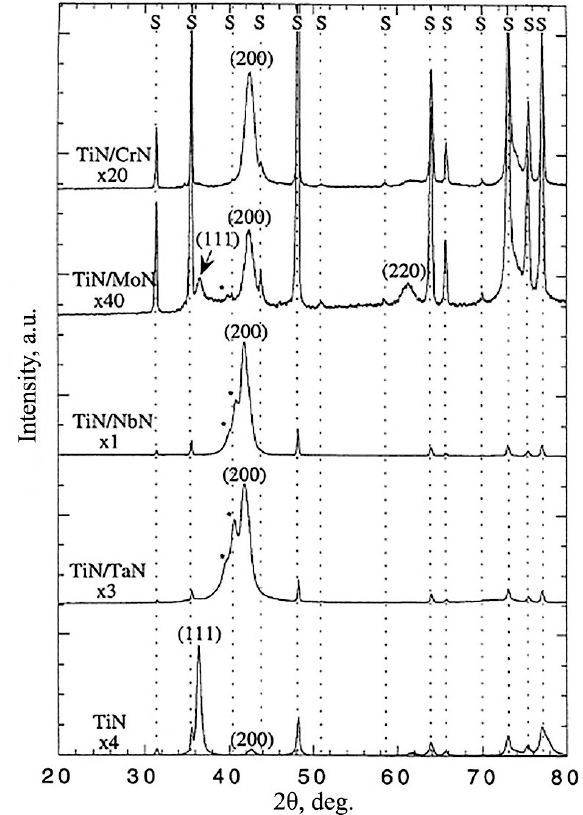
Figure 6. X-ray diffraction patterns of TiN/CrN, TiN/MoN, TiN/NbN and TiN/TaN coatings; “S” and “*” indicate peaks from the carbide substrate and the superlattice, respectively. Reprinted with permission from [96] 1998 Elsevier.